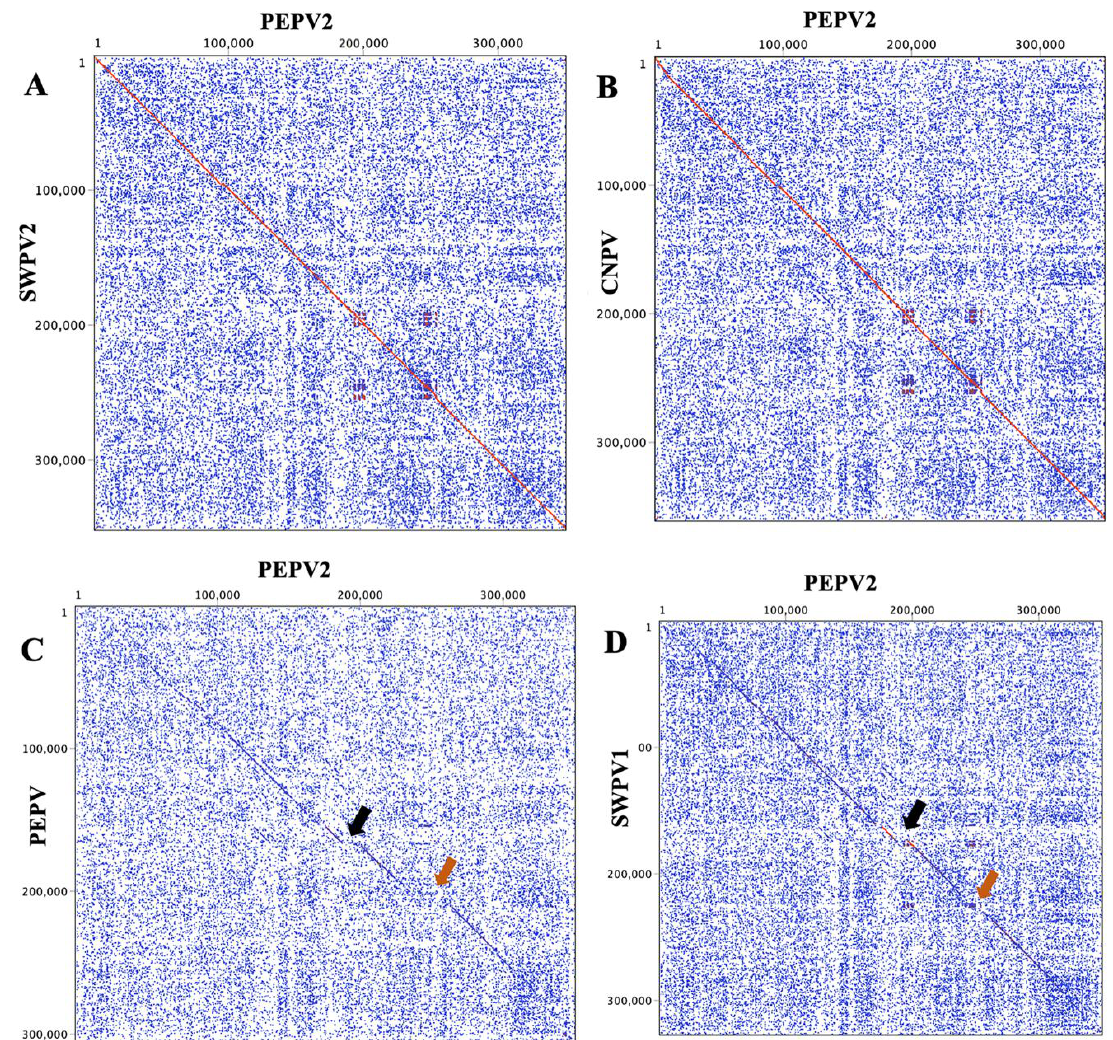
Figure 2. Dot plots of the PEPV2 genome (x-axis) vs. other sequenced avipoxvirus genomes (y-axis). ( A ) PEPV2 vs. SWPV2, ( B ) PEPV2 vs. CNPV, ( C ) PEPV2 vs. PEPV, and ( D ) PEPV2 vs. SWPV1. The Classic colour scheme was chosen in Geneious (version 10.2.2) for the dot plot lines according to the length of the match, from blue for short matches to red for matches over 100 bp long. Black arrows indicate the first region of major difference (PEPV2-158 to -170) and orange arrows indicate the second region of major difference (PEPV2-214 to -236). Window size = 12.